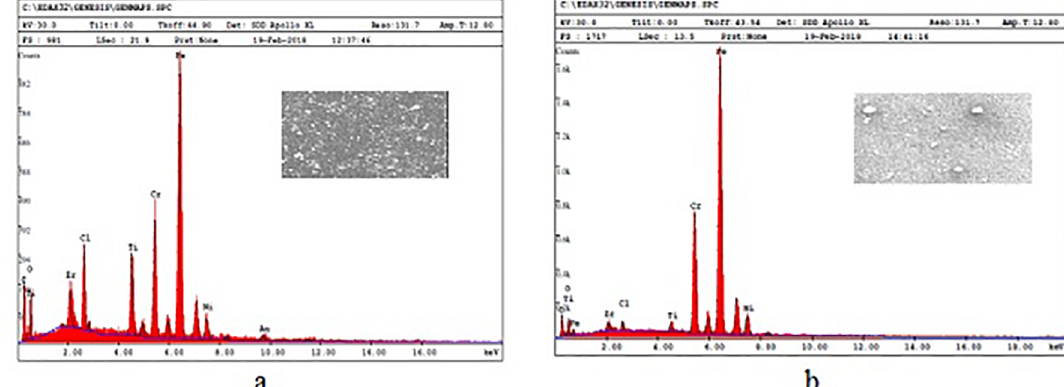
-ZrO coating with a mix ratio of 2 2